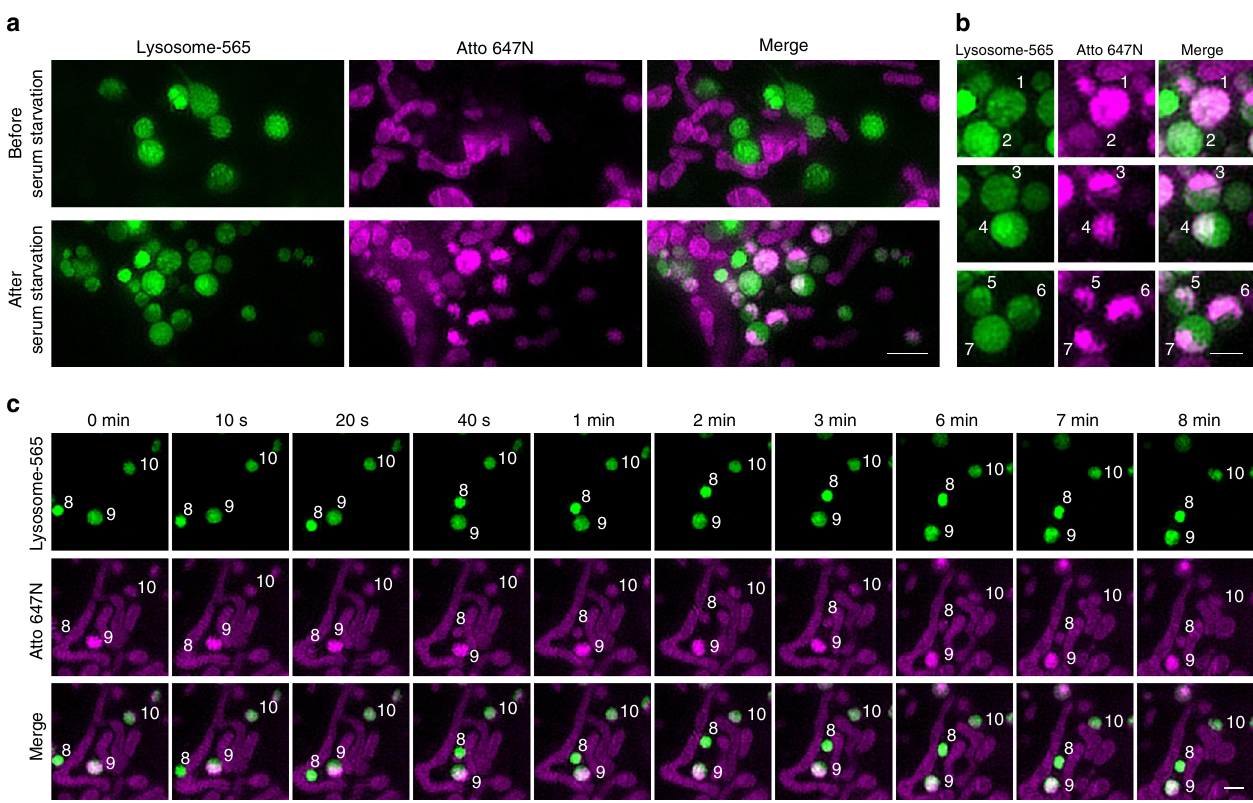
Fig. 4 Determination of co-localization of mitochondria with lysosomes during mitophagy. a Dual-color SIM images of lysosomes (green) and mitochondria (magenta) before and after serum starvation in live U2OS cells. Live U2OS cells stained with Lysosome-565 (green) and Atto 647N (magenta) were incubated with culture medium without fetal bovine serum (FBS) for 4 h before imaging. b Representative mitochondria within lysosomes with diverse shapes. c Time-lapse SIM images reveal dynamics of the autolysosomes after serum starvation (more frames are shown in Supplementary Movie 6). Each SIM frame was acquired over 270ms (i.e., a raw data exposure time of 30 ms). For the time-lapse images, the time interval between each dual-color SIM image was set to 10 s; representative images of consecutive SIM frames are displayed. Scale bars, a 2 μ m, and b , c 1 μ